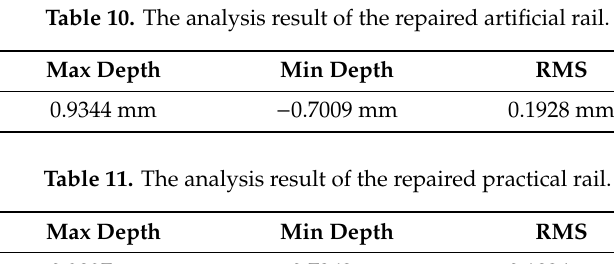
Figure S1: The practical rail of 50 Kg / m and its surface PCM, Figure S2: The result of the scratch-recognition algorithm performed on the rail-surface PCM of the practical rail, Figure S3: The acquisition of the scratch-data PCM, Figure S4: The triangulation of the PCM, Figure S5: The final complete closed mesh models of the scratch-data of the practical rail, Table S1: The values of the parameters used in the scratch-recognition algorithm, Table S2: The calculation results of the extension vector, Table S3: The time required in the